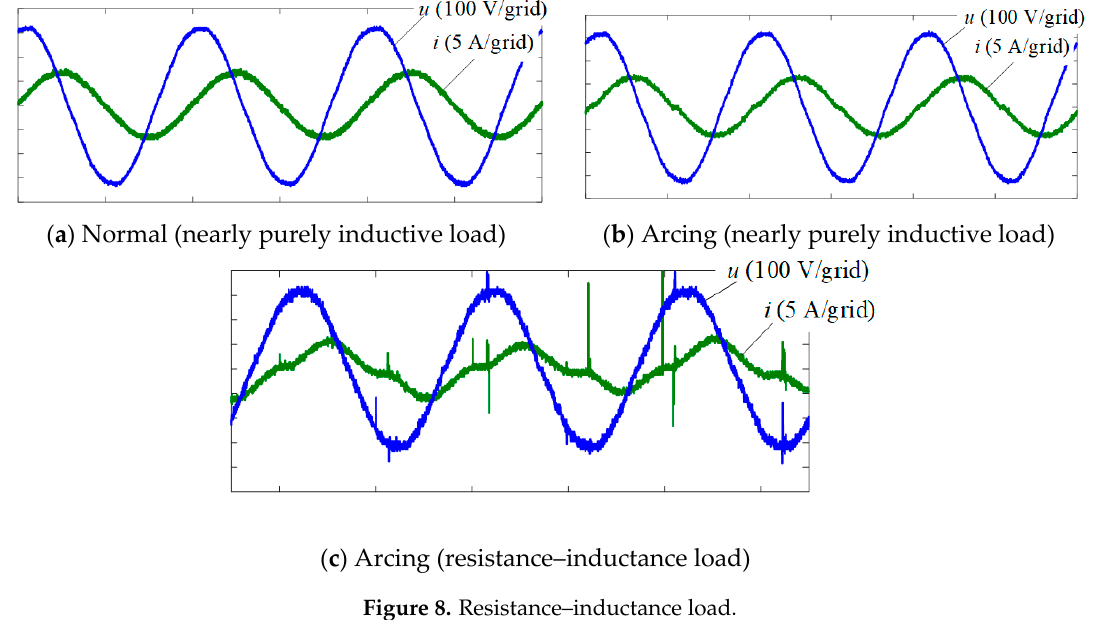
Figure 9. Equivalent circuit of resistance–inductance load.